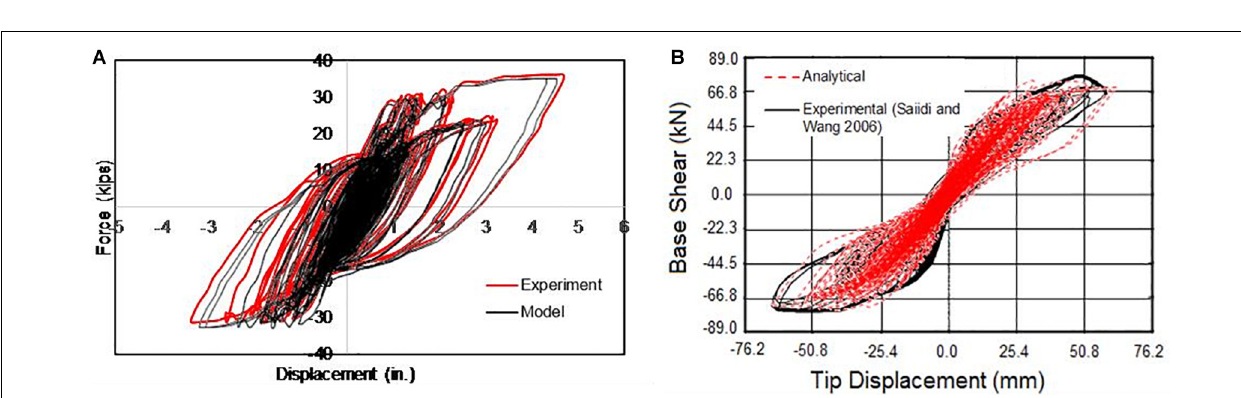
FIGURE 8 | Comparison with experimental result (A) simulating cyclic degradation of Steel-RC pier and (B) SMA-RC bridge pier.